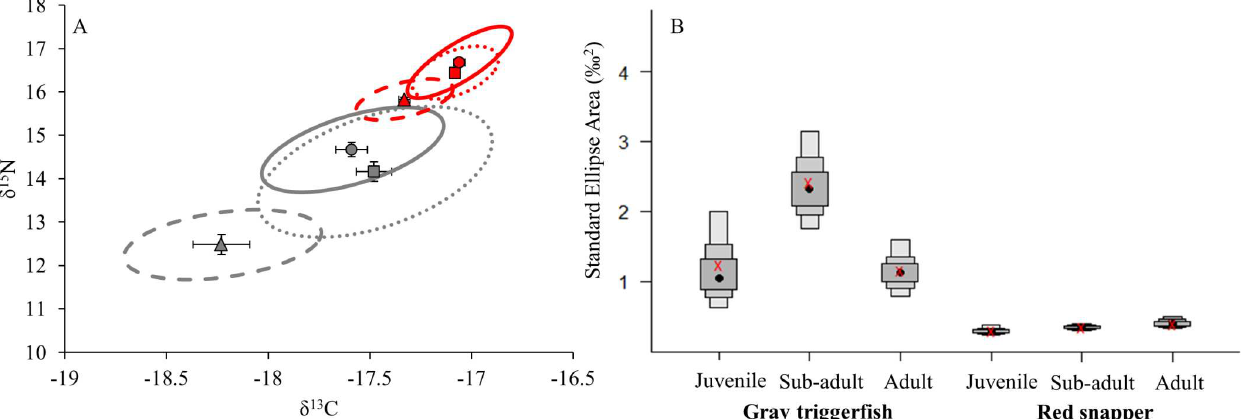
Fig 5. Species core isotopic niches and Bayesian credibles by size class, based on standard ellipse areas. (A) Standard ellipse areas contain 40% of the data for gray triggerfish (gray), and red snapper (red). Stable isotope means and ellipses (SEA c ) are shown for juveniles (triangles, dashed ellipses), sub-adults (squares, dotted ellipses), and adults (circles, solid ellipses); error bars represent the standard error. (B) Bayesian credible intervals for gray triggerfish and red snapper standard ellipse areas by size class. Black points represent the mean, while gray boxes represent 50, 75, and 95% credible intervals. Red x’s represent SEA corrected for sample size (SEA c